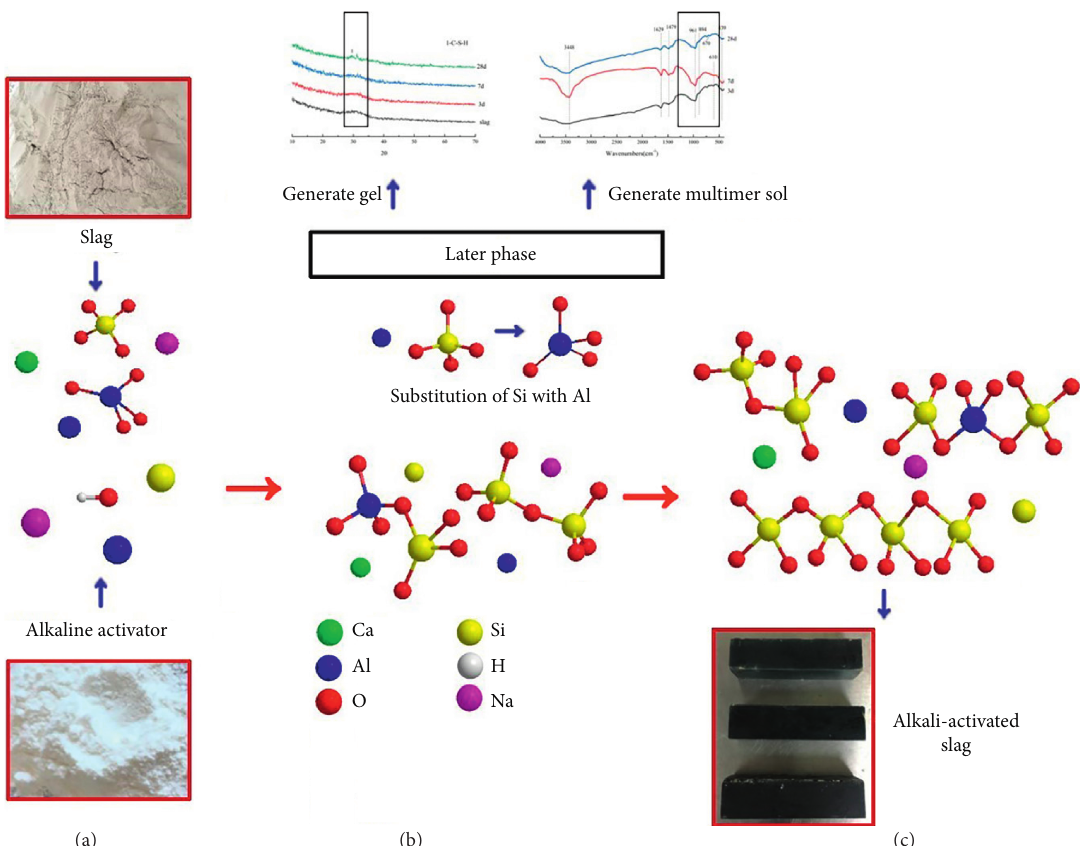
Figure 13: Schematic diagram of the main hydration process of fresh and hardened slag based NaAlO